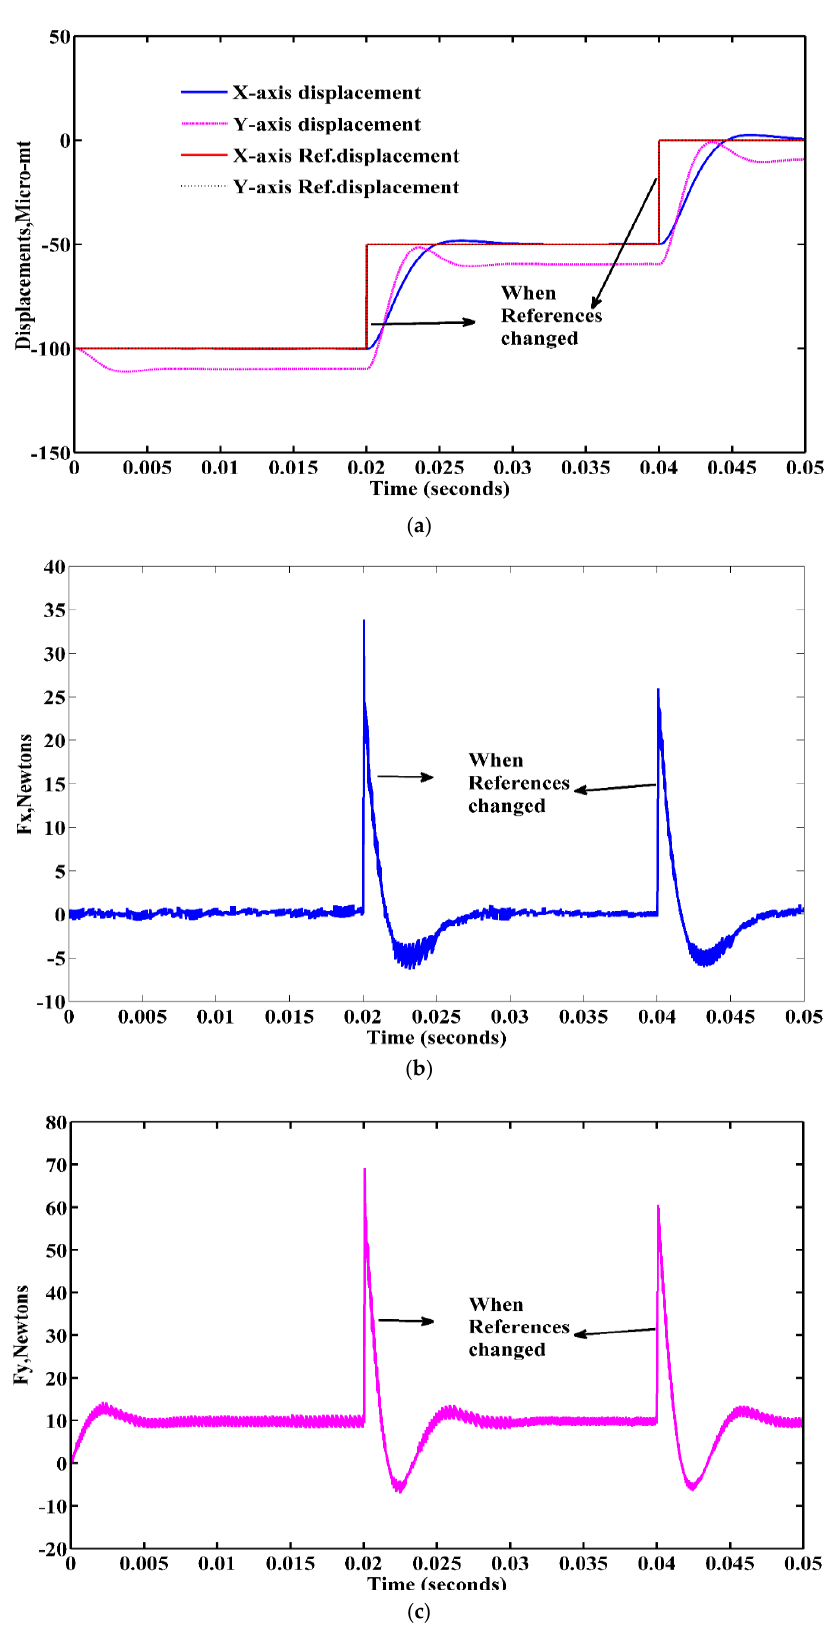
Figure 20. Third Quadrant suspension parameters. ( a ) Rotor Xand Y-axis dispalcements when references are changed; ( b )Suspension force in the X direction; ( c ) Suspension force in the Y direction.